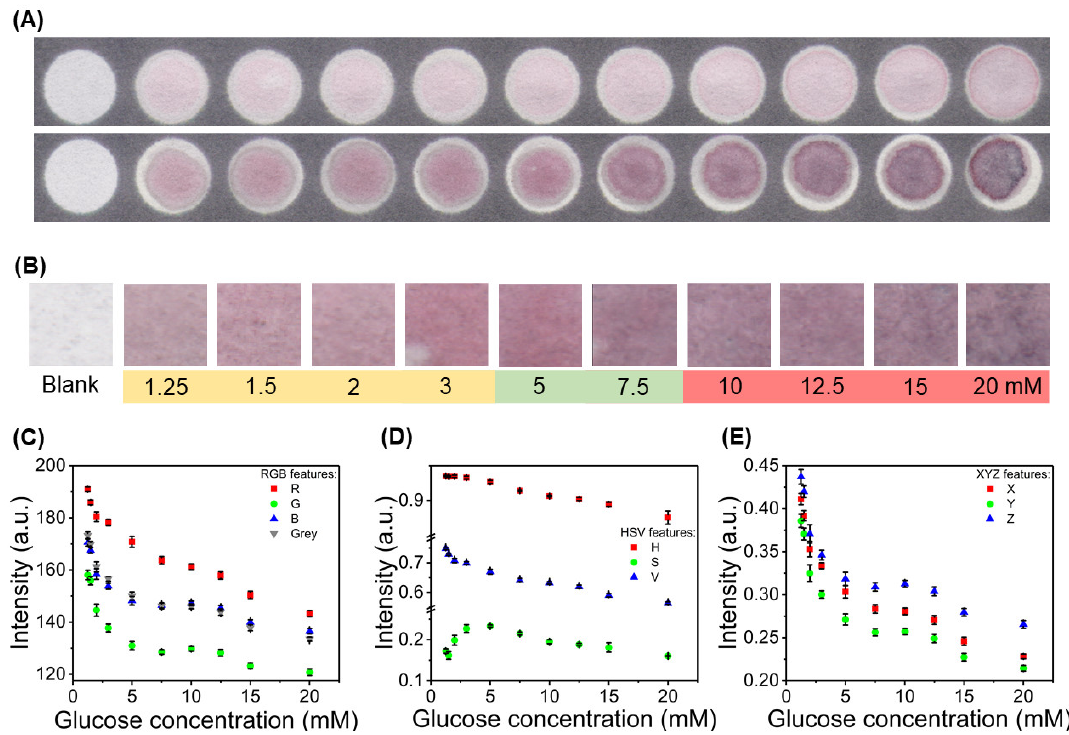
Figure 3. Color signal for the optimized assay condition (30 mM HAuCl 4 and 3 M NaOH) and digital color analysis of Red, Green, Blue (RGB), Hue, Saturation, and Value (HSV), and XYZ color space features. ( A ) Comparison between color signal for the optimized condition and an alternative condition with an appropriate color range variation for glucose measuring, showing marked di ff erences in color intensity and hue. ( B ) Crop sections extracted from the reaction zones using a custom image processing software, showing the variation of the color signal with increasing glucose concentrations. ( C ) Analysis of RGB color space features correlated with glucose concentration. ( D ) Analysis of HSV color space features correlated with glucose concentration. ( E ) Analysis of XYZ color space features correlated with glucose concentration (n = 6).